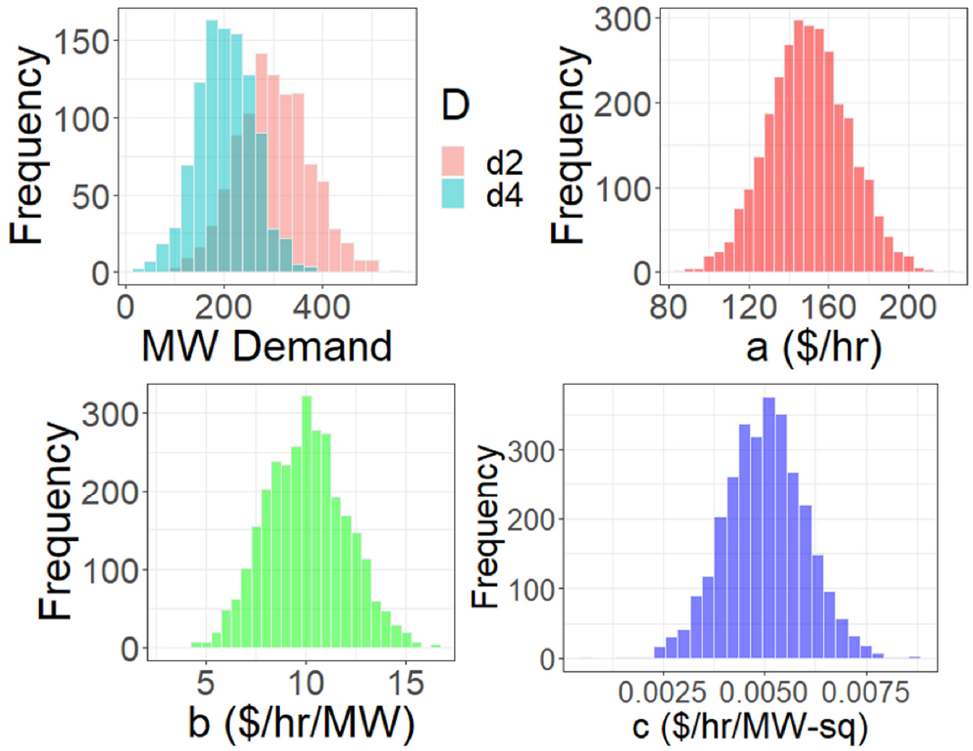
Figure 10. Distributions of nodal demands and cost coefficients (4-Bus System).